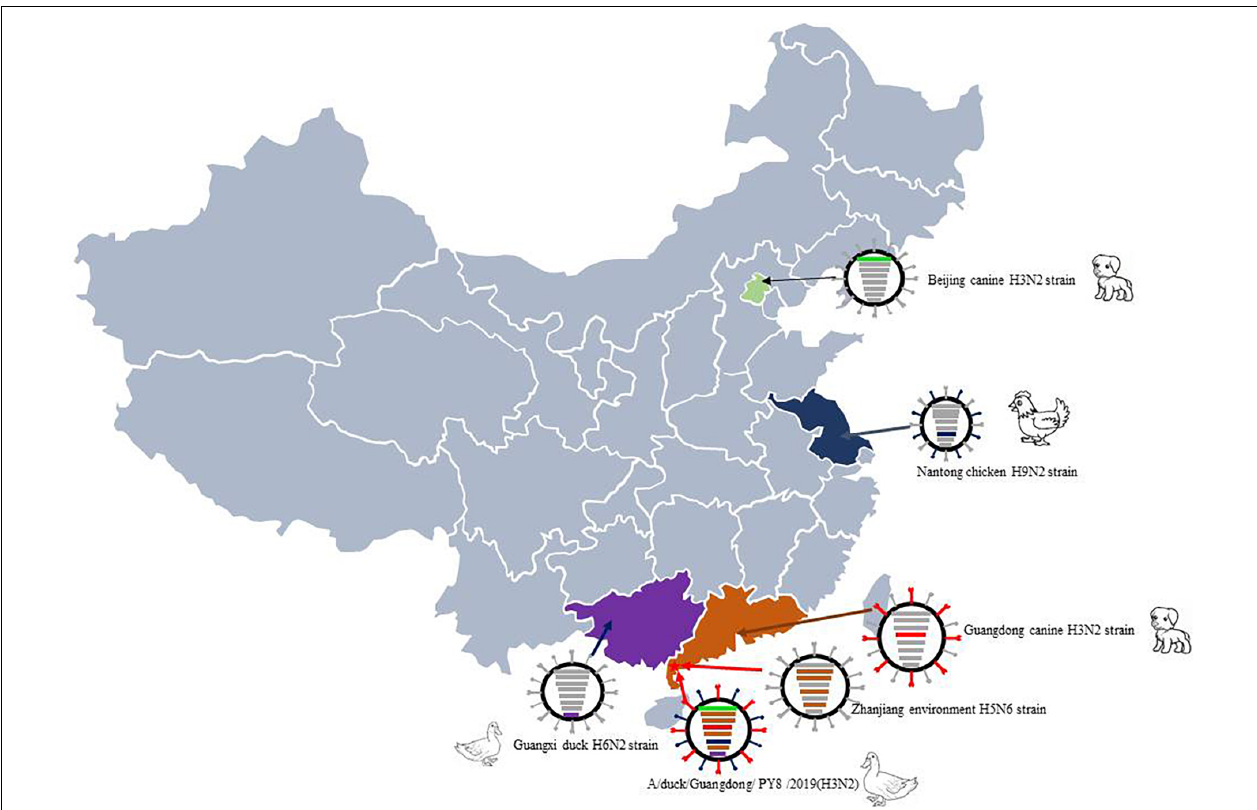
FIGURE 4 | Sampling point and the proposed reassortment and transmission of H3N2. The sampling point is marked with a red star, and the location of the case of canine infection with influenza A subtype H3N2 virus is marked in yellow. Guangdong-origin segments are colored in red, Guangxi-origin segments are colored in purple, and Jiangsu-origin segments are colored in